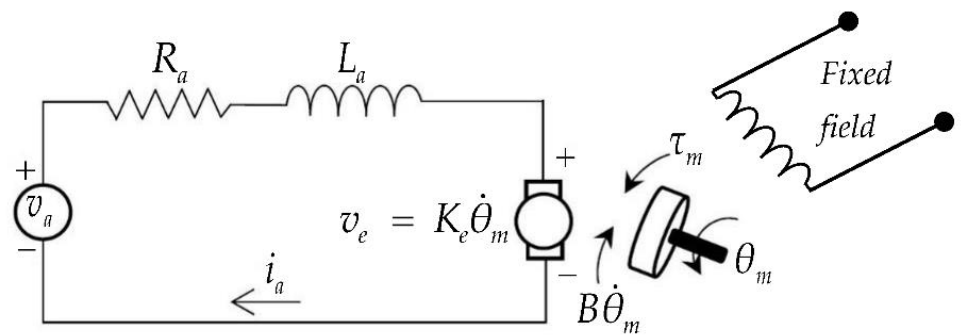
Figure 4. A basic electrical circuit and free body diagram of a DC motor.